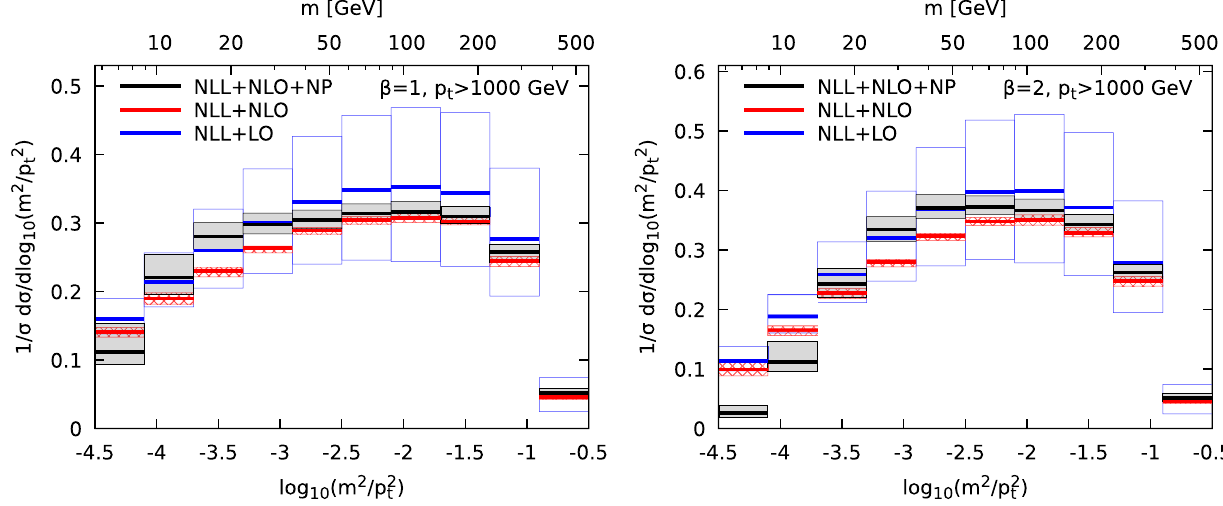
Fig. 2 Resummed and match theoretical predictions for the Soft Drop jet mass distribution, for two different values of the angular exponent β = 1 (left) and β = 2 (right), z cut = 0 . 1 and R = 0 . 8. The colours correspond to different accuracy of the calculation, as detailed in the